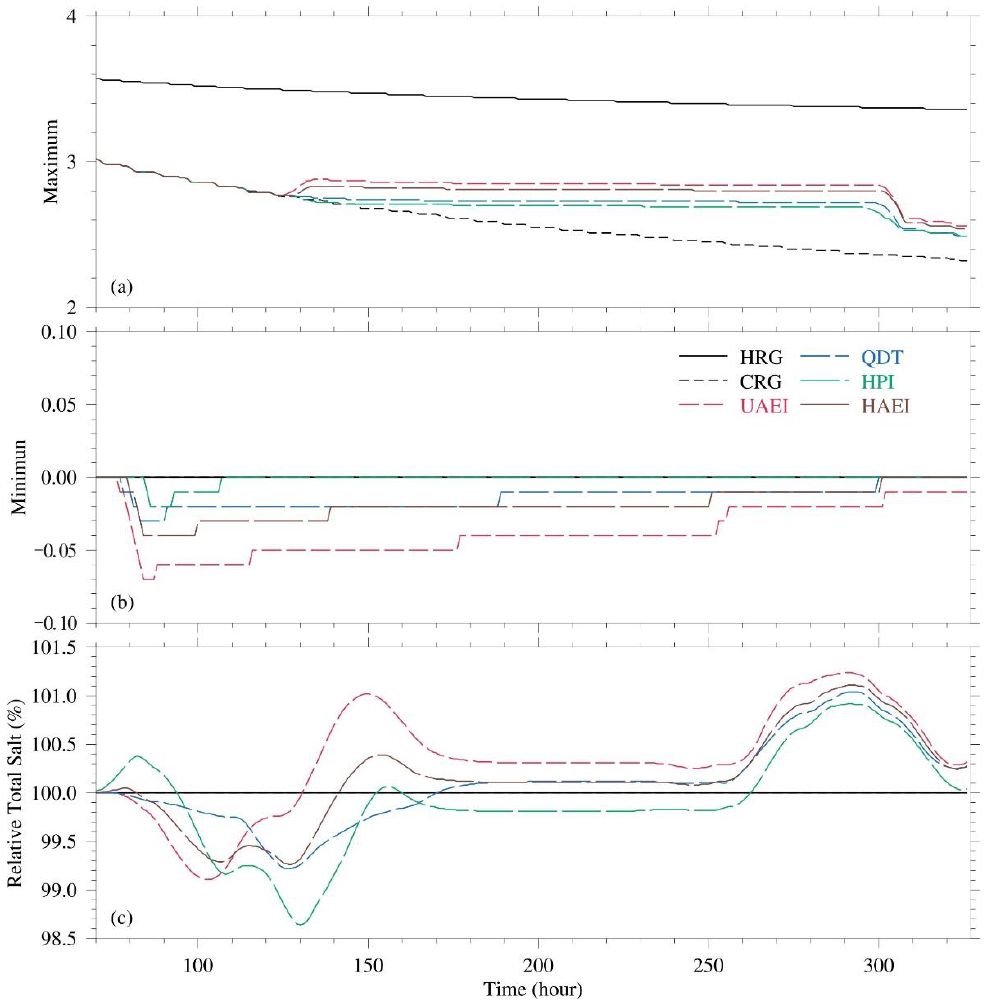
Figure 5. Comparison of the modelled ( a ) maximum salinity, ( b ) minimum salinity, and ( c ) relative total salt in the whole domain. HRG: high-resolution grid; CRG: coarse-resolution grid; UAEI: upwind AEI scheme; QDT: quadratic interpolation scheme; HPI: HSIMT parabolic interpolation scheme; HAEI: HSIMT AEI scheme.